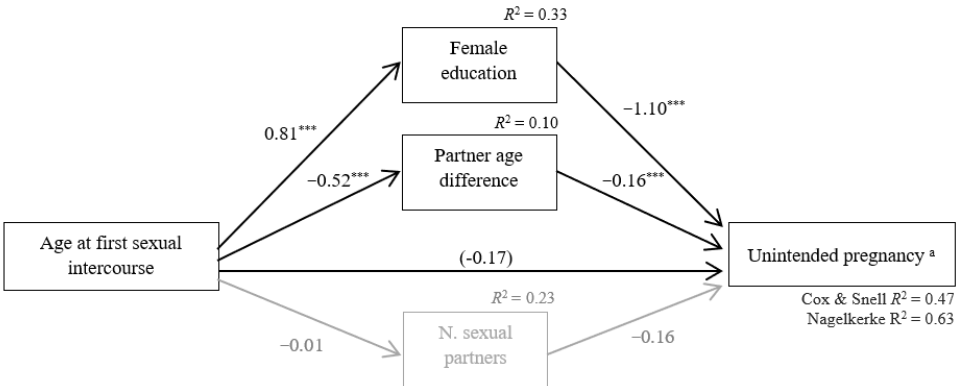
Figure 3. Statistical diagram of the parallel mediation model for the presumed association between age at first sexual intercourse (AFSI) and unintended pregnancy through female education and partner age difference and number of sexual partners while controlling for ethnicity, socioeconomic status, religious beliefs, place of residence, and time since sexual initiation. Path values represent unstandardized regression coefficients. In the arrow linking AFSI and unintended pregnancy, the value inside parentheses represents the direct effect of AFSI on unintended pregnancy after controlling for the mediators. The total effect of AFSI on unintended pregnancy is not available because unintended pregnancy is a dichotomous variable. The significant indirect effects are represented by paths in black. Non-significant indirect effects are represented by paths in gray. Significant mediators: female education and partner age difference. Non-significant mediators: number of sexual partners. Note. N = 613. a Reference category: No. *** p < 0.001.